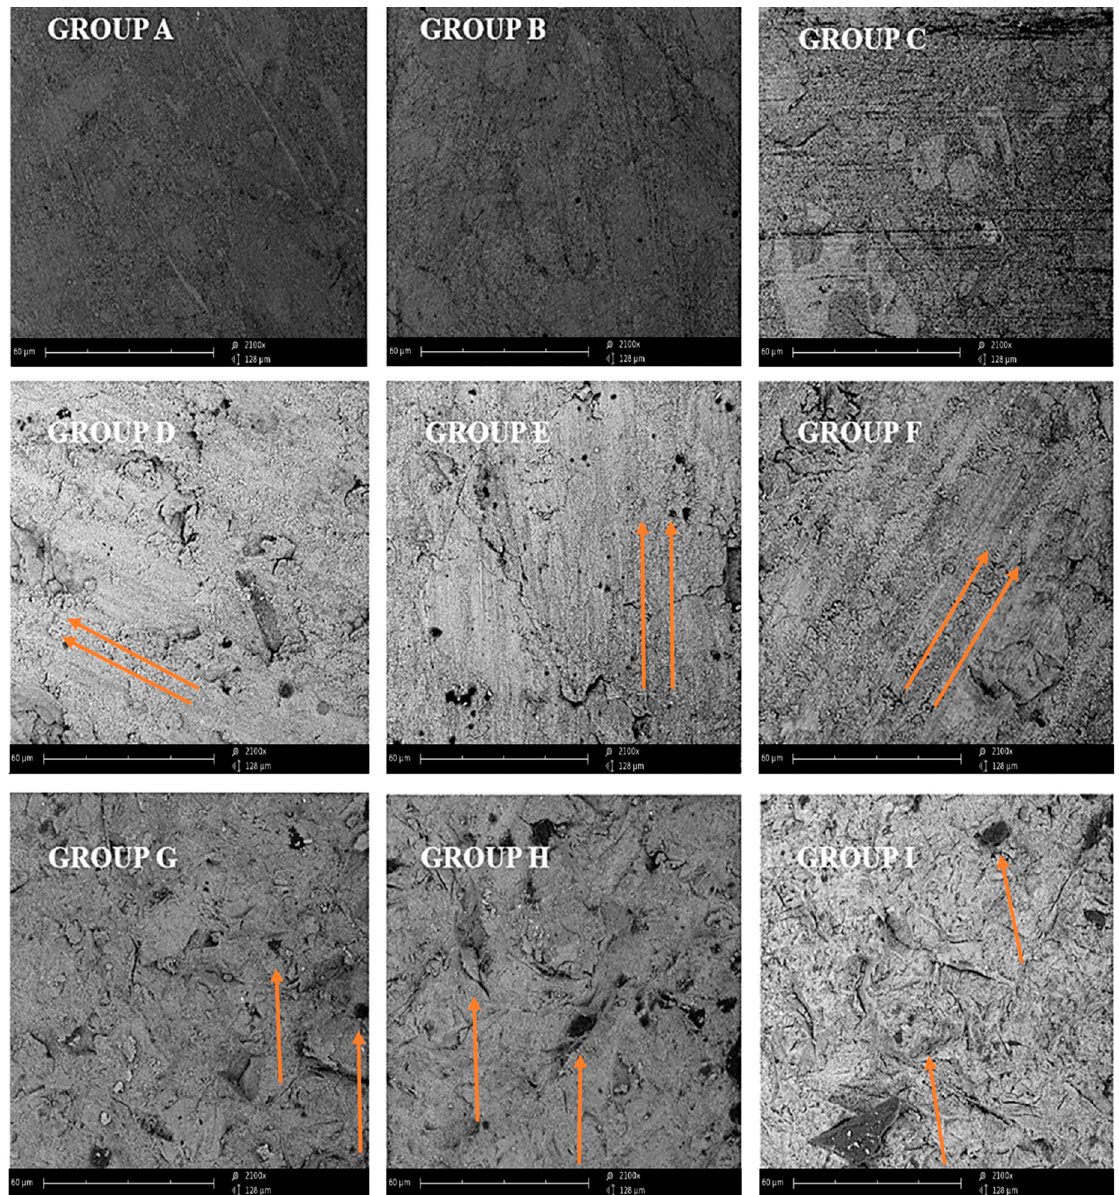
Figure 1. SEM images (2100x). Voltage: 5kV. Type of electron: secondary electron (SE). Groups A, B and C show a surface without irregularities; groups D, E and F show evident parallel streaks resulting from the bur action (arrows indicates the parallel streaks); groups G, H and I, the sandblasted samples, show the highest number of microcavities (arrows indicate microcavities).